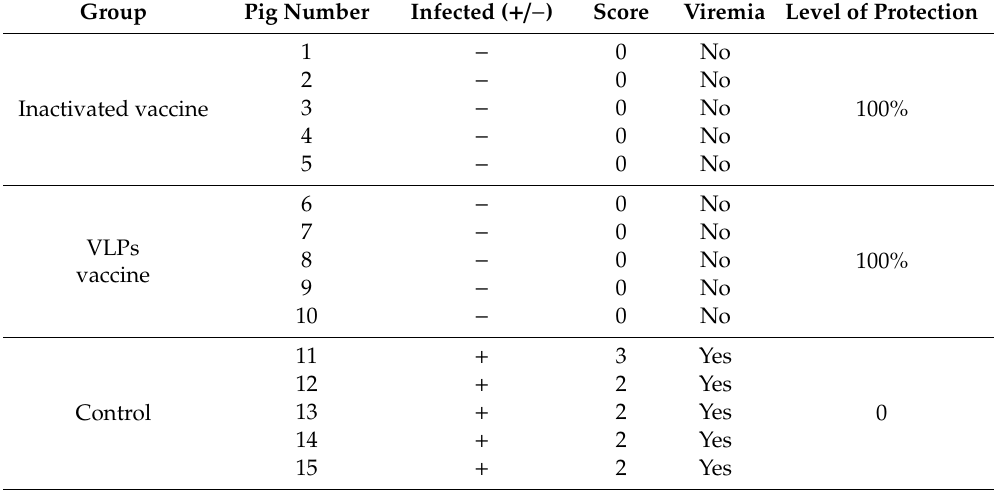
Table 2. Protection against SVA